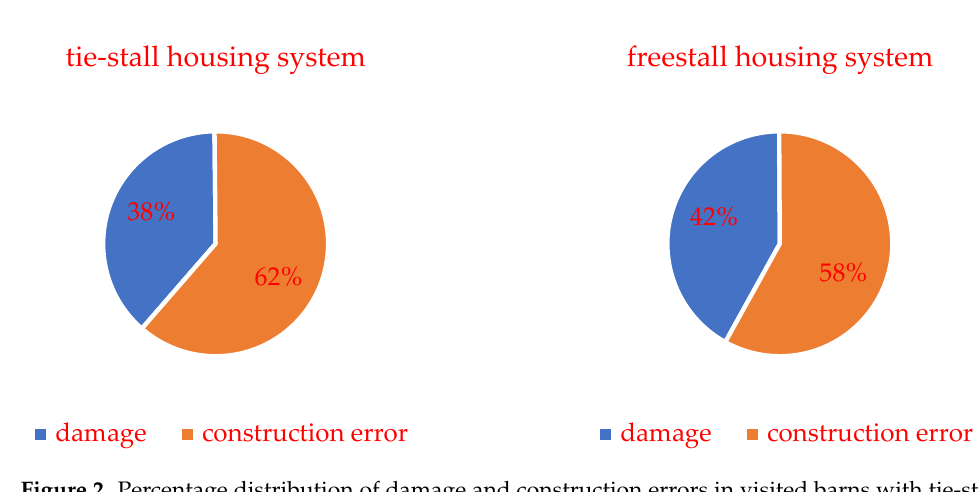
Figure 2. Percentage distribution of damage and construction errors in visited barns with tie-stall and freestall housing system.